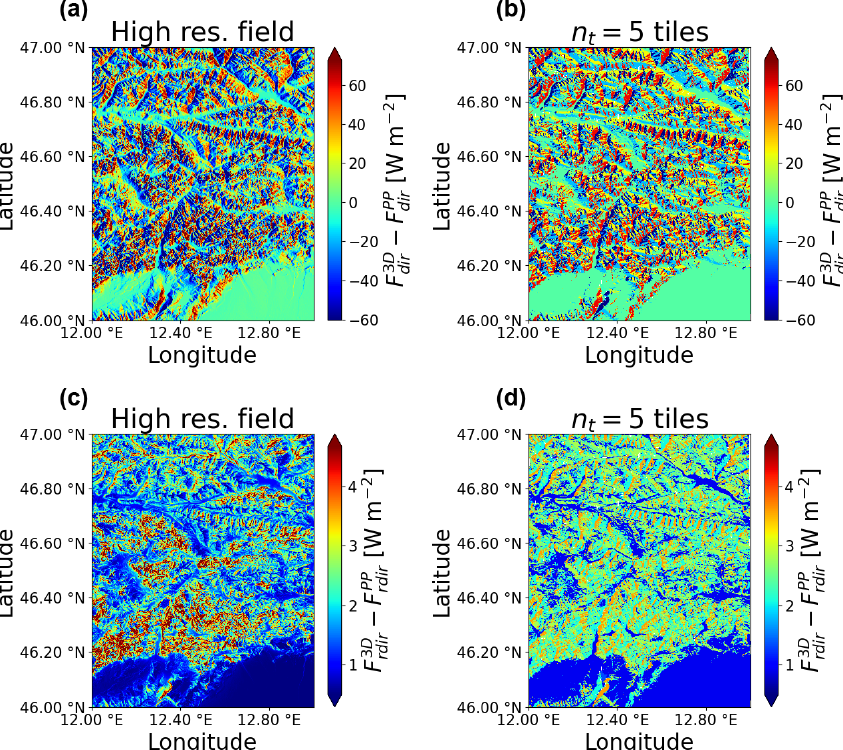
Figure 14. Downward radiation differences between 3D and PP fluxes for high-resolution predictions (a, c) and predictions using five tiles (b, d) for each flux component. Results are shown for a representative case of clear-sky conditions, and cos θ 0 = 0 . 4 is used for direct flux (a, b) and reflected direct flux (c, d)